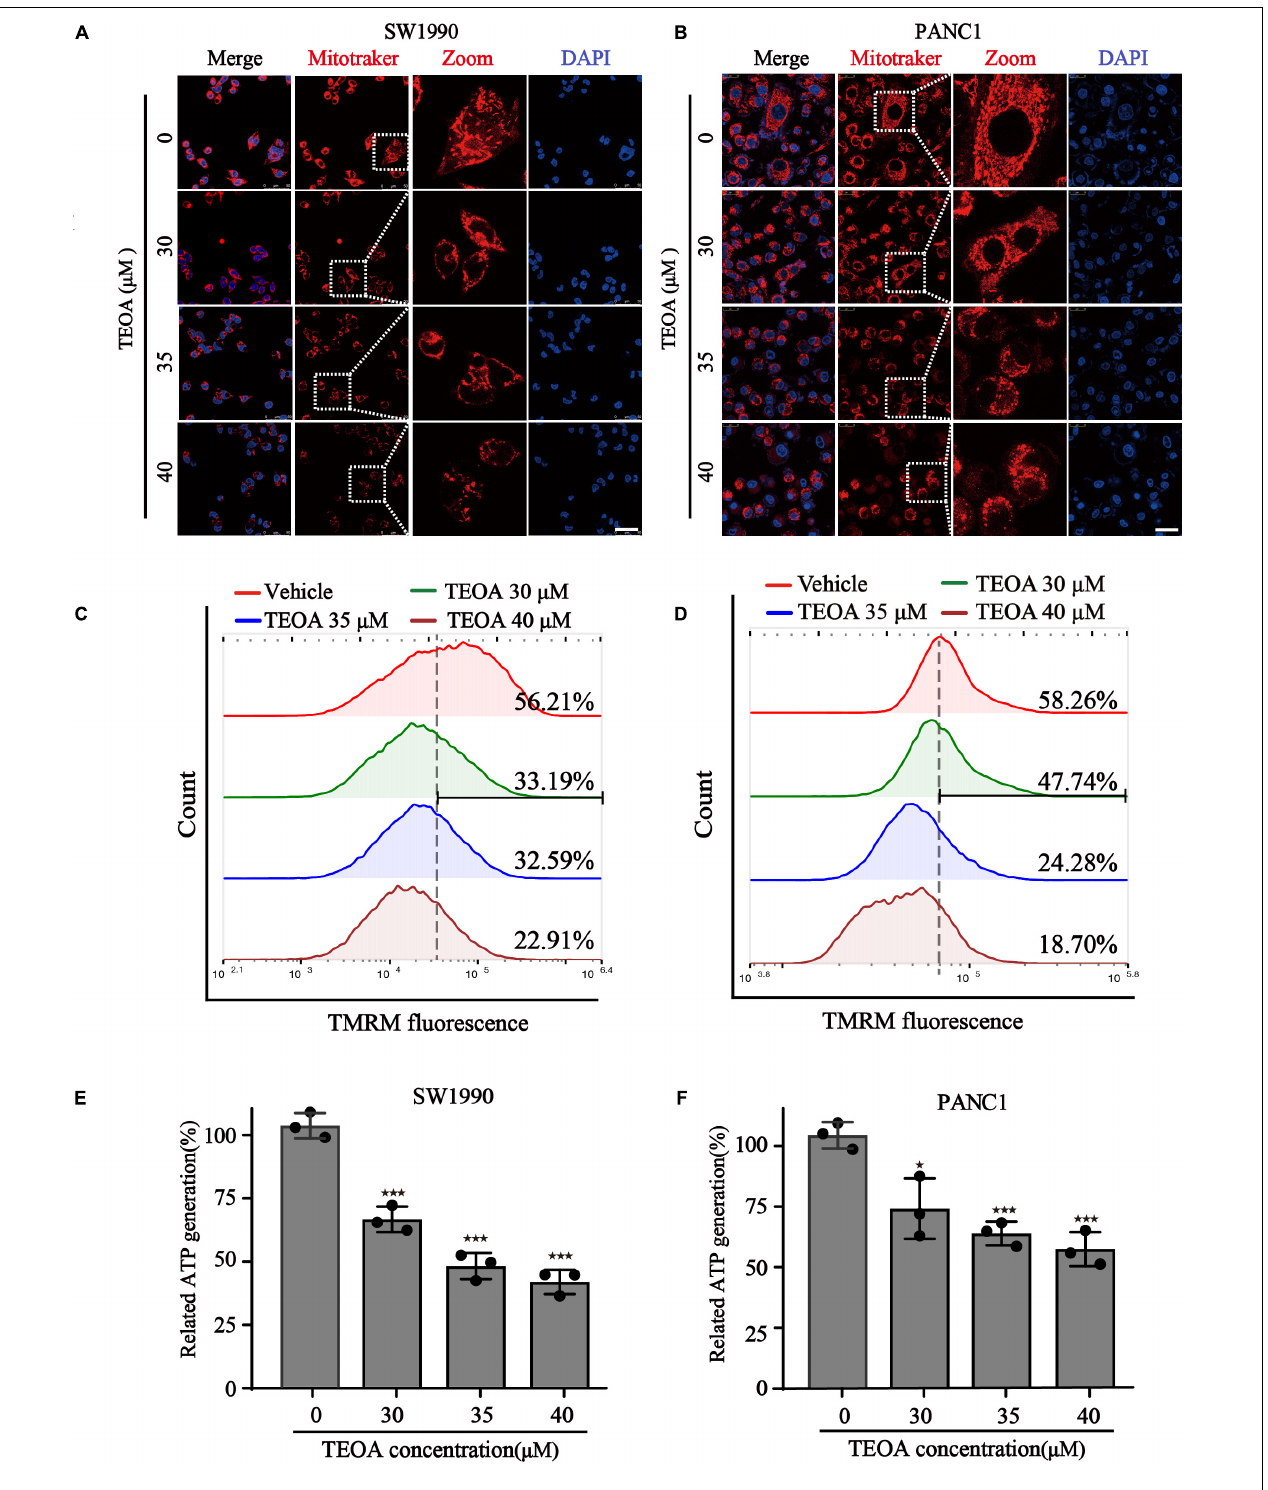
FIGURE 3 | TEOA induced mitochondrial dysfunction of pancreatic cancer cells. (A,B) To observe the morphology of mitochondria, SW1990 and PANC1 cells treated with the indicated concentration of TEOA for 8 h and stained with Mitotracker probe (200 nM), DAPI (10 µ g/ml), and then photographed by confocal laser microscope. Scale bars 50 µ m. (C,D) To assess the changes of mitochondria membrane potential, TEOA treated SW1990 cells and PANC1 cells were stained with TMRM probe for 30 min and followed by flow cytometry measurement. (E,F) SW1990 and PANC1 cells were treated with the indicated concentration of TEOA, then ATP levels were measured. ATP levels of TEOA treated PANC1 cells were measured ( (cid:70) p < 0.05; (cid:70)(cid:70) p < 0.01; (cid:70)(cid:70)(cid:70) p < 0.001, versus control).